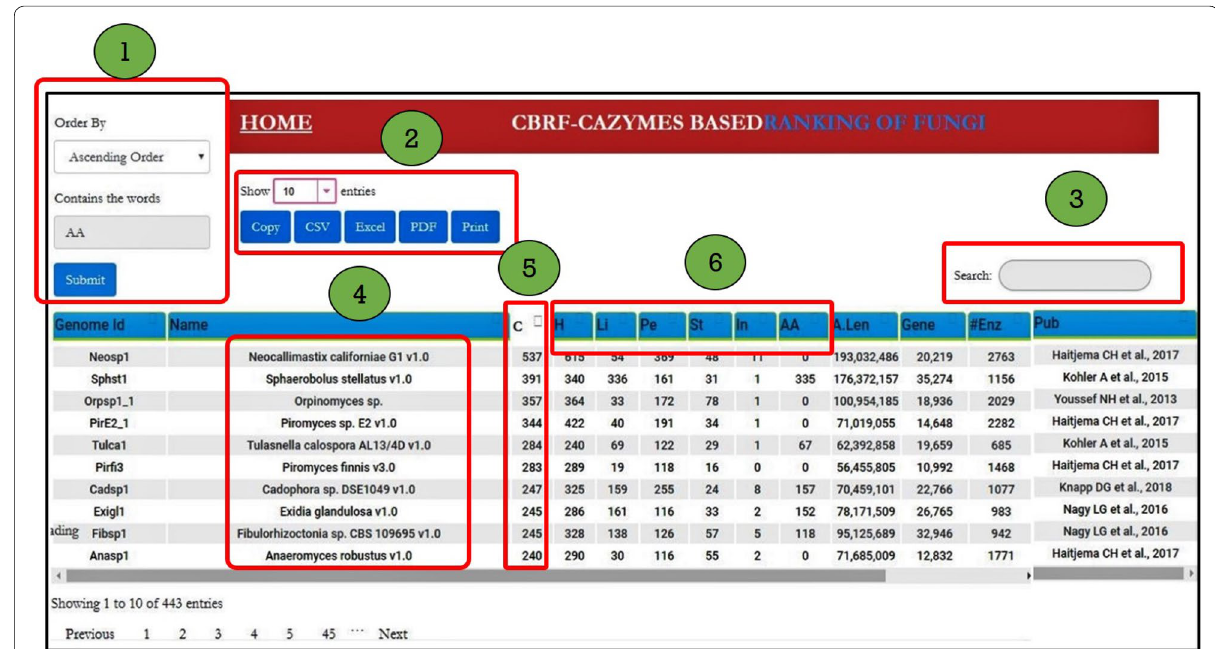
Fig. 5 Snapshot of CBRF-CAZymes-based ranking of fungi web database showing different sorting functionalities for retrieving the fungal information based on the search of interest [1—sorting functionality (provides two sorting options—ascending order and descending order); 2— the final sorted list of fungi can be exported in different file formats including: in.CSV, M.S. Excel, .PDF or print; 3—“Search functionality” to quickly search for a specific fungus of user’s interest; 4—lists the scientific names of all the top-sorted fungi, e.g.: in this window it only lists top 10 as we have selected only to show top 10 fungi; 5—we have specifically included the total fungal ability to degrade cellulose (C); 6-hemicellulose (H), lignin (L), pectin (P), starch (S) and inulin